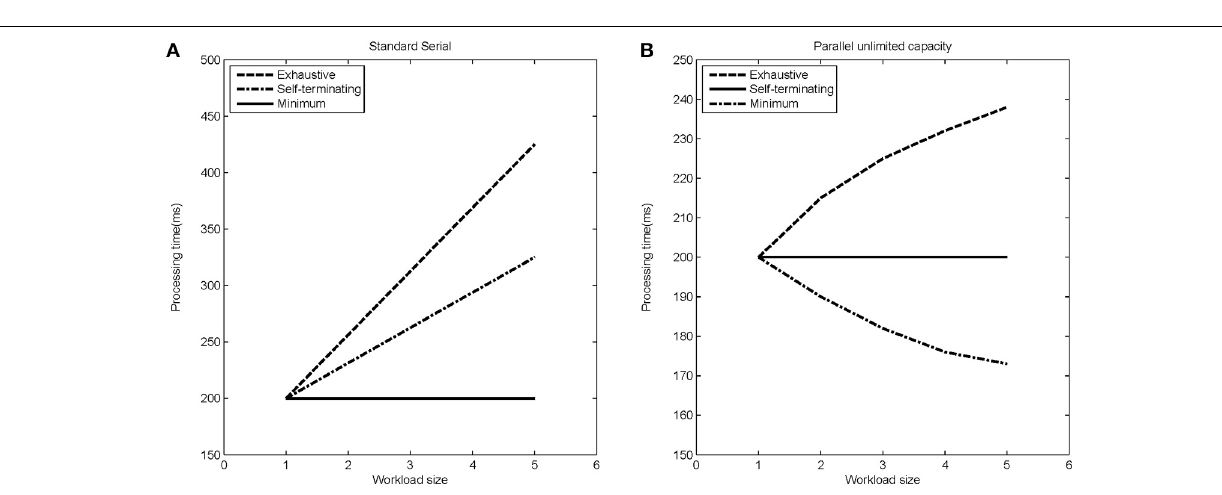
FIGURE 5 | Expected processing time as a function of load-set size for different stopping rules (exhaustive, self-terminating, and minimum) for (A) the standard serial modal, and (B) the parallel unlimited capacity processing